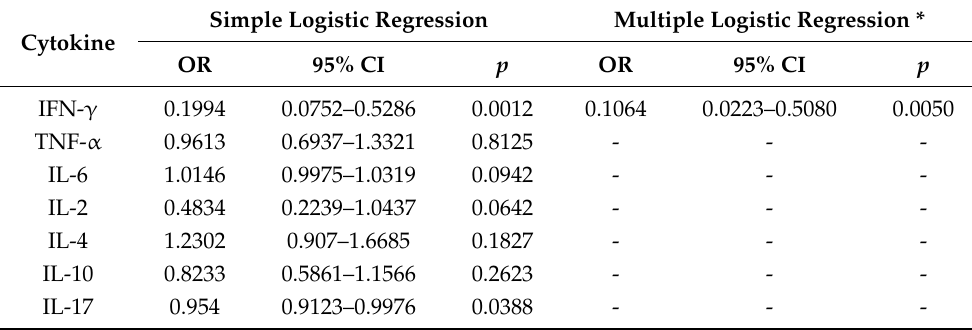
Table 5. Evaluation of cytokine levels by logistic regression between the group with pulmonary TB and extrapulmonary TB. Simple Logistic Regression Multiple Logistic Regression * Cytokine